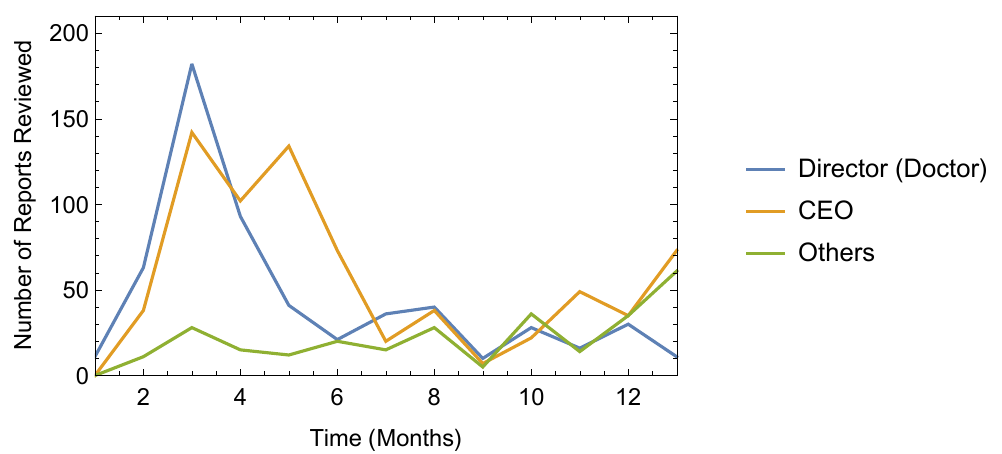
Figure 7. Number of reports reviewed each month by Director of Business Management (Doctor), CEO, and